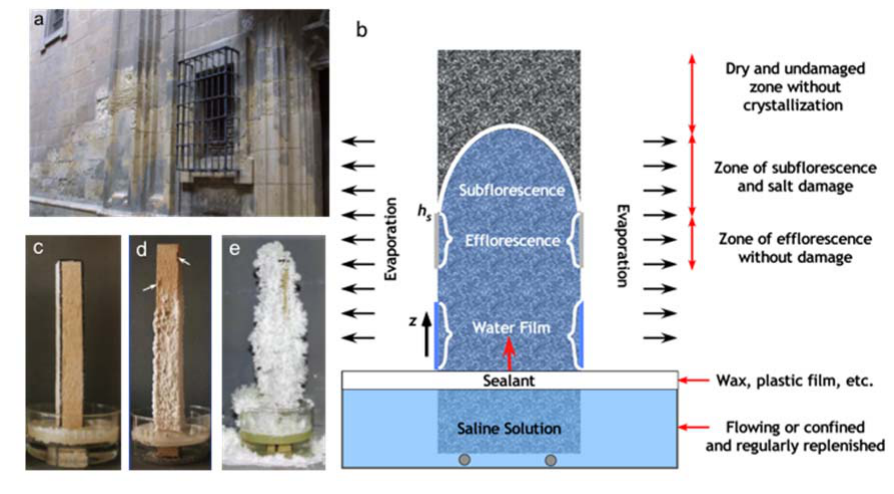
Figure 3. Salt damage via capillary rise. a) Example of a porous calcarenite stone wall (Granada Cathedral, Spain) affected up to a certain height (marking the maximum height of capillary rise) by salt damage; b) scheme showing the partial immersion test for salt damage via capillary rise, representing: capillary rise, evaporation and zones of efflorescence and subflorescence (adapted from [13]); different sealants have been proosed as paraffin wax [5] and flexible plastic films [13], the solution max be still and replenished [13] or in continuous flow [58], most preferably such samples are placed in a chamber of which the environmental conditions are controlled [5,7], and the sample is placed on supports so that the solution wets the bottom surface [7]; c) image of the partial immersion test set up for the case of a porous limestone subjected to sodium chloride crystallization test; d) same as (c) after four weeks solution flow ‐ through and evaporation. Efflorescence in the lower part of the stone prism is observed, while subflorescence in the upper part leads to scaling and loss of material (arrows); and e) porous limestone subjected to sodium chloride crystallization in the presence of 3 mmol/L sodium ferrocyanide. Just in two days, massive salt extraction as efflorescence takes place in the presence of this crystallization inhibitor (image reproduced with permision from [51]).